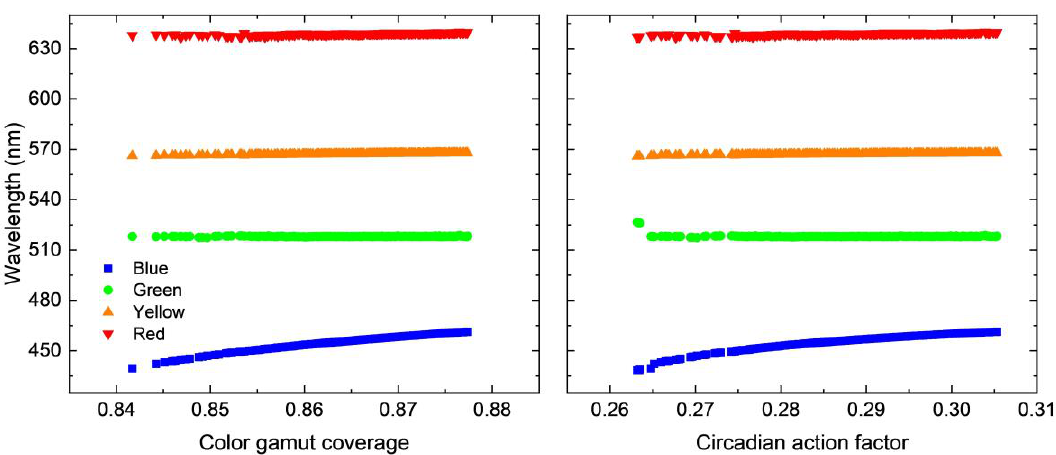
Figure 5. Correlations between objectives (color gamut coverage (CGC) and circadian action factor (CAF)) and the central wavelengths of RGB micro-LEDs and the yellow phosphors, where the bandwidth of the yellow phosphor was 60 nm (RGBW-type).